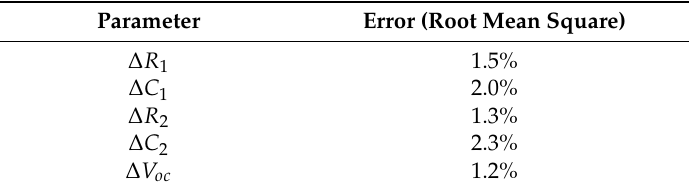
Table 1. Fitting error for battery parameters.